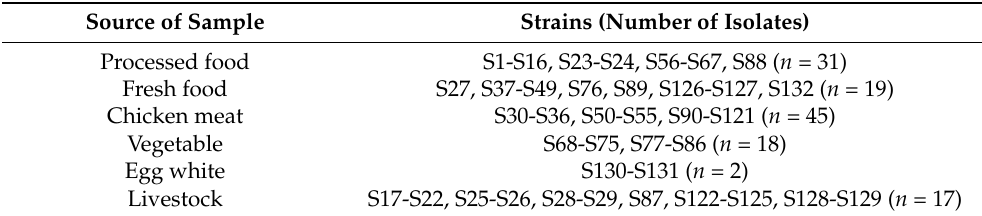
Table 2. List of isolates identified as Salmonella species by MALDI–TOF